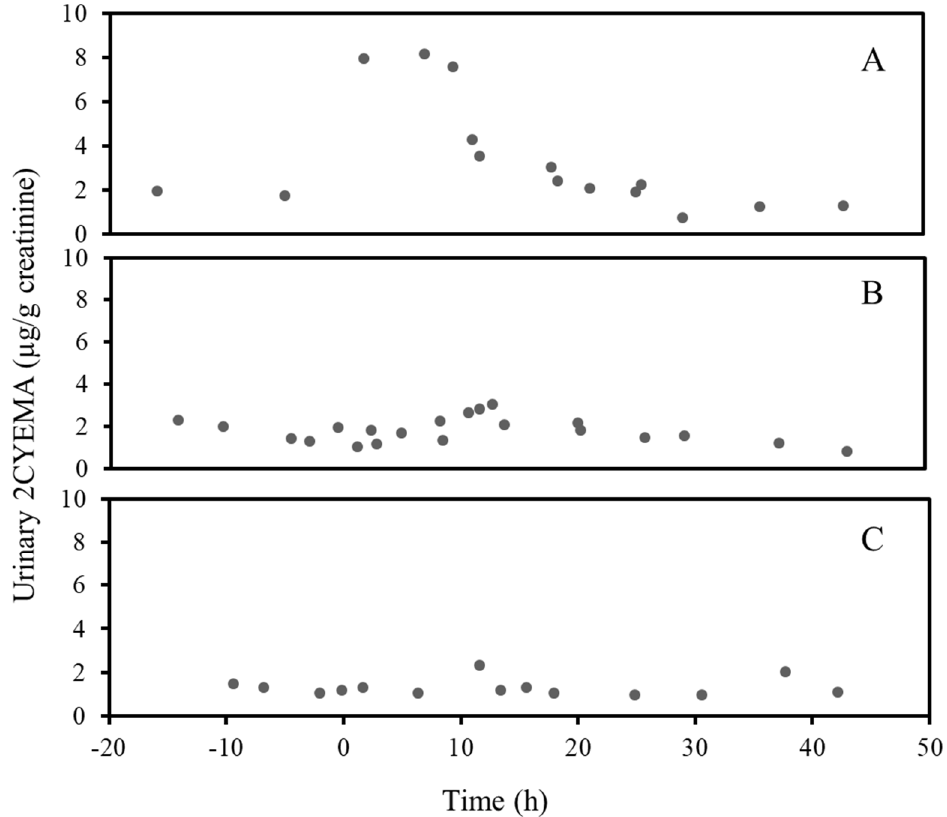
Figure 1. Creatinine-corrected urine 2CYEMA ( µ g / g creatinine) concentrations over time before and after smoking of a cannabis joint ( A ) vaping of cannabis ( B ) or ingestion of a cannabis brownie ( C ) by an occasional cannabis user.